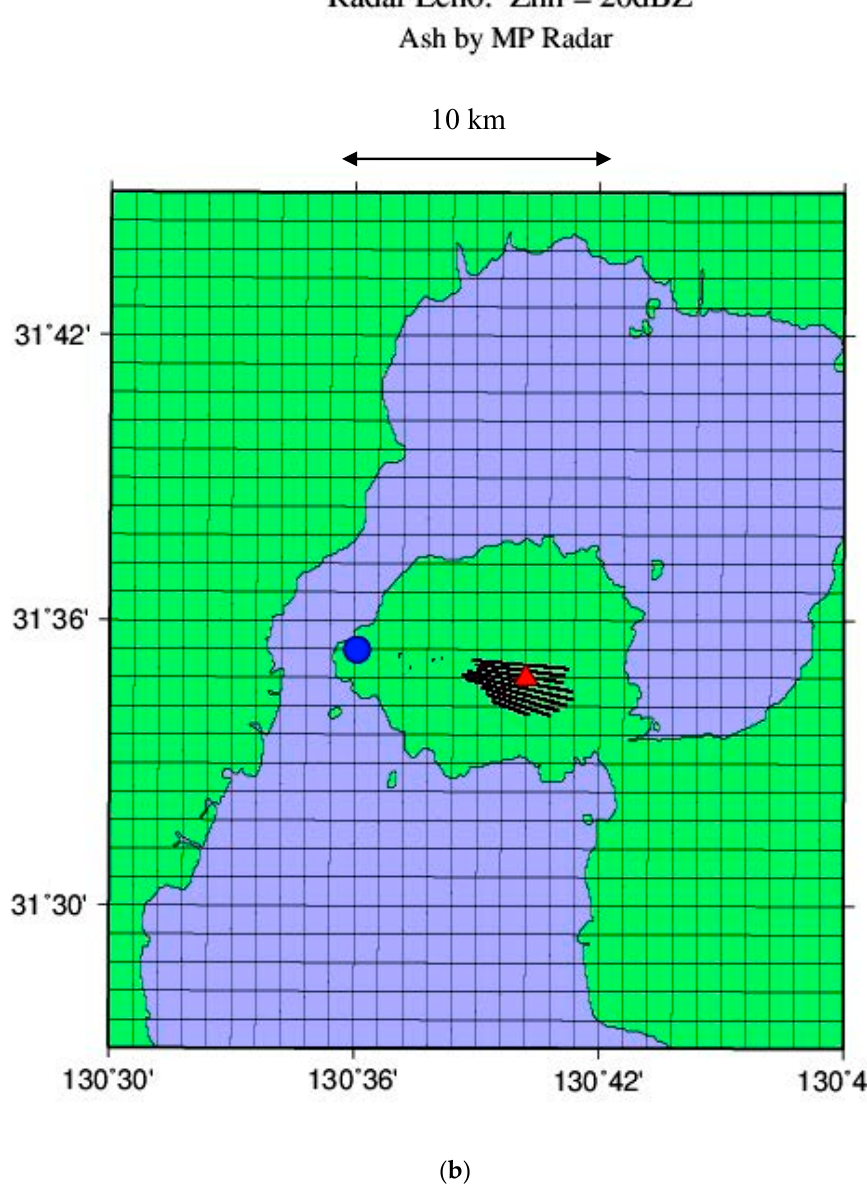
Figure 6. Particle distribution of airborne ashes by multi-parameter (MP) radar at 17:28 JST, projected onto the ground for the reflectivity factor (Zhh) larger than ( a ) 10 dBZ and ( b ) 20 dBZ. Blue dot indicates the location of MP radar at Sakurajima Volcano Research Center (SVRC).